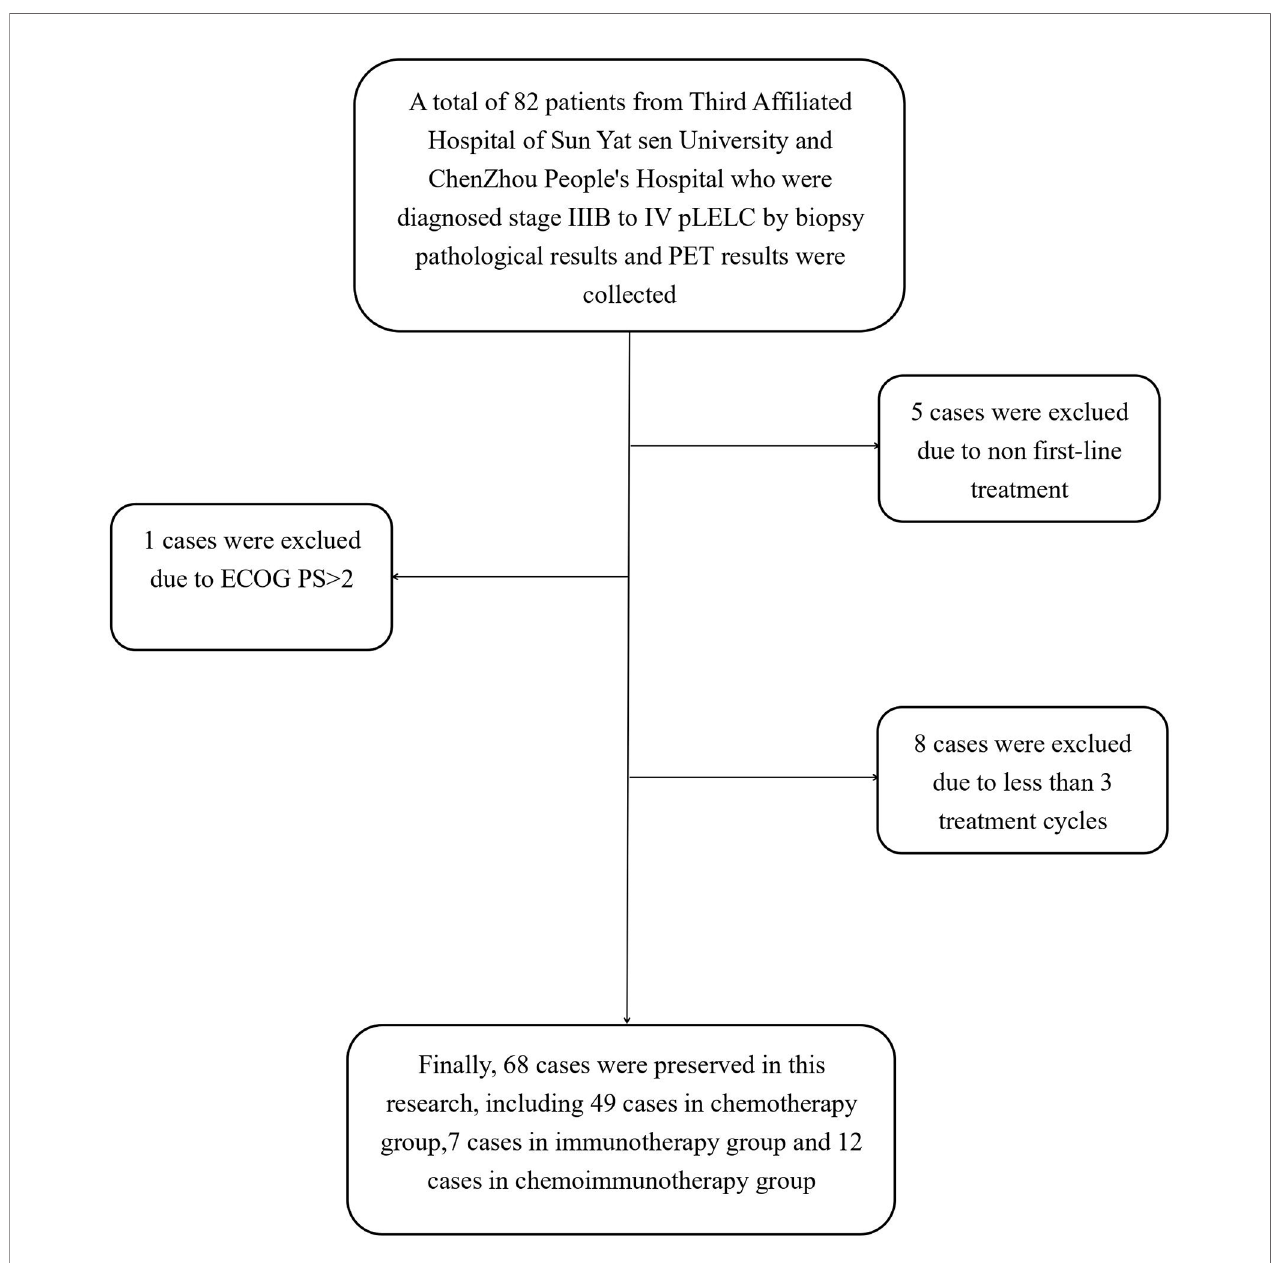
FIGURE 1 | Flow-chart of this